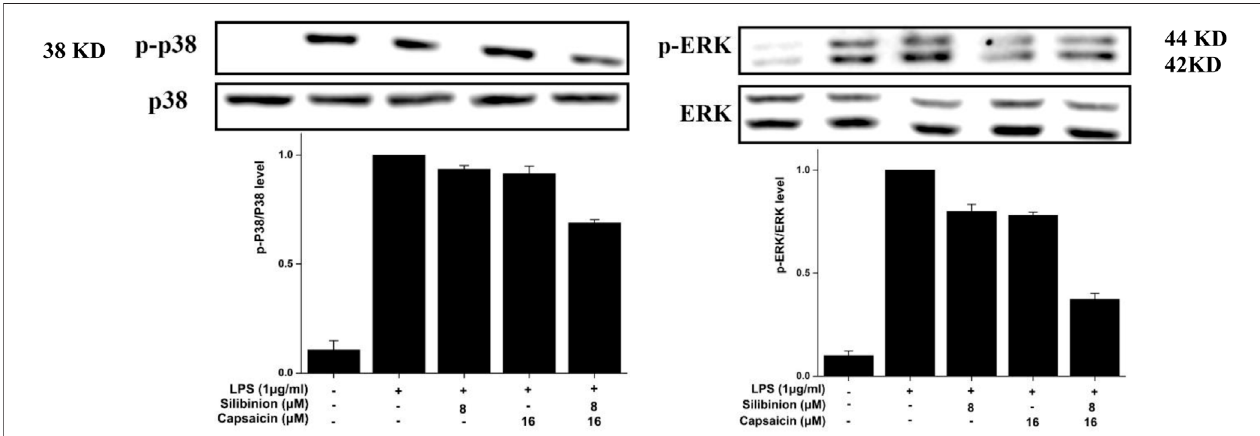
FIGURE 7 | Effect of silibinin and capsaicin on the LPS-induced MAPK pathway. After separated by SDSPAGE (8%), transfer to the nitrocellulose membrane, and block for 1 h in non-fat milk (5%), the sample was incubated with the primary antibodies p-p38, p38, p-ERK, and ERK overnight at 4 ° C, respectively, and subsequently incubation with the secondary antibody for 1 h.